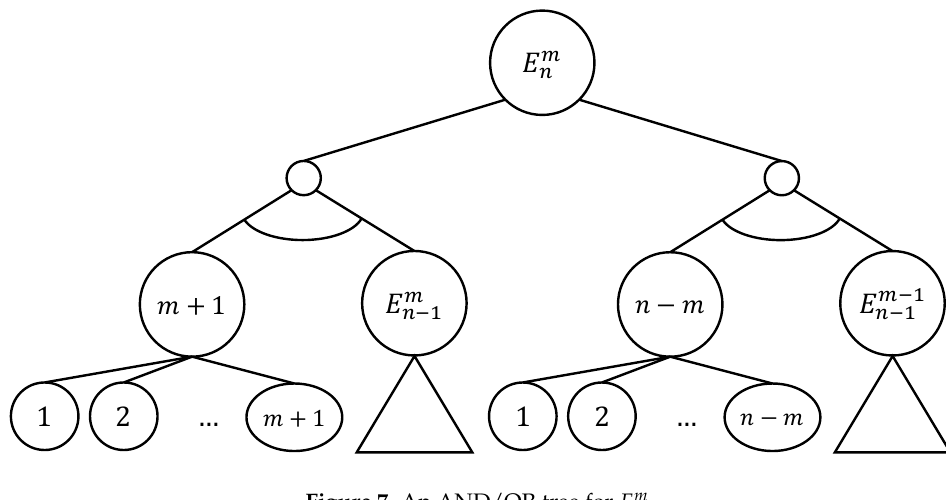
Figure 7. An AND/OR tree for E m n .